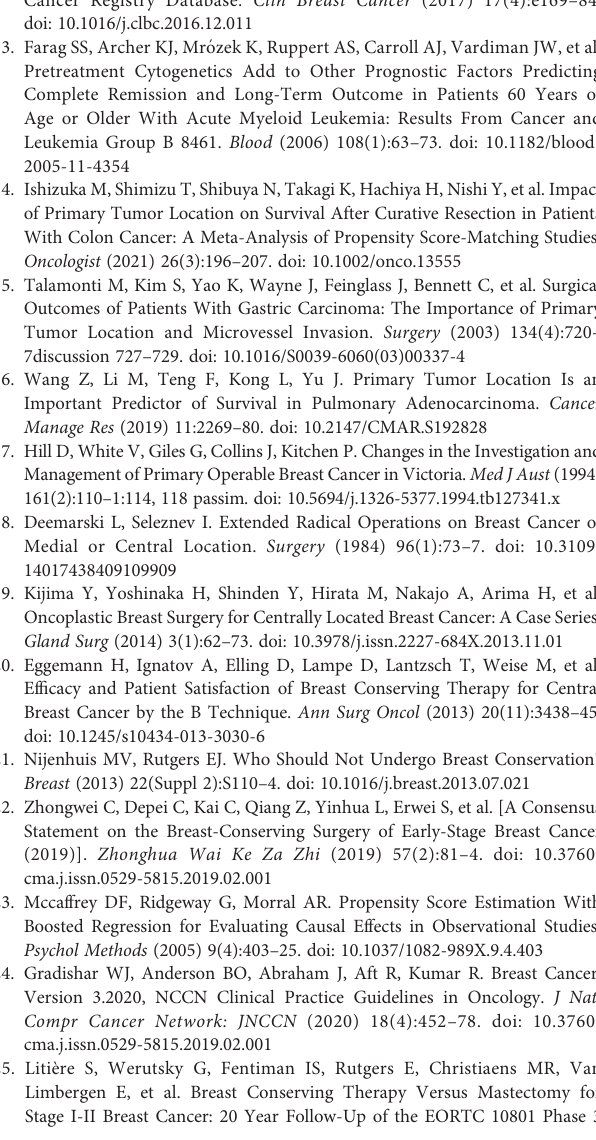
Supplementary Figure 1 | Kaplan-Meier Curves for OS by Treatment Type for All Patients, Strati fi ed by Age at Diagnosis: (A) Age <40 years. (B) Age of 40-49 years. (C) Age of 50-59 years. (D) Age of 60-69 years. (E) Age ≥ 70 years. BCSS, breast cancer speci fi c survival; BCT, breast-conserving therapy. Supplementary Figure 2 | Kaplan-Meier Curves for OS by Treatment Type for All Patients, Strati fi ed by Sex: (A) Female. (B) Male. BCSS, breast cancer speci fi c survival; BCT, breast-conserving therapy. Supplementary Figure 3 | Kaplan-Meier Curves for OS by Treatment Type for All Patients, Strati fi ed by Race: (A) White. (B) Black. (C) A/PI. (D) AI/AN. BCSS, breast